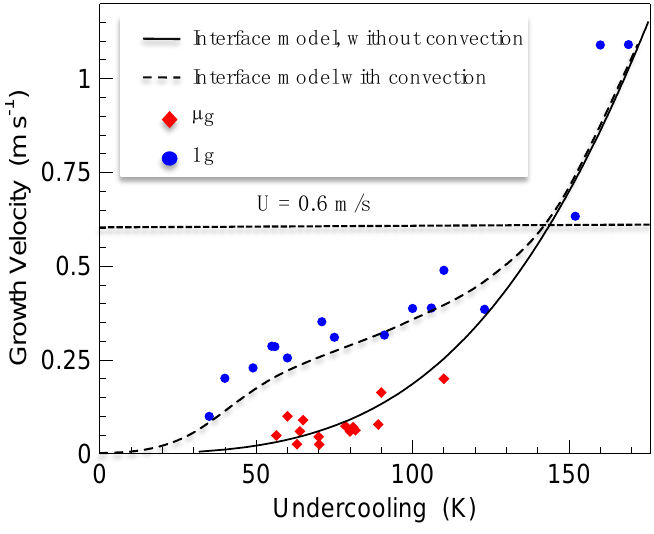
Figure 6. Dendrite growth velocity of B2 β-phase of Al undercooling measured under terrestrial conditions (circles) and in reduced gravity (diamonds). The solid line represents the prediction of dendrite growth theory without convection and the dashed line with convection. U denotes the speed of fluid flow inside an electromagnetically levitated droplet as estimated by magneto-hydrodynamic simulations